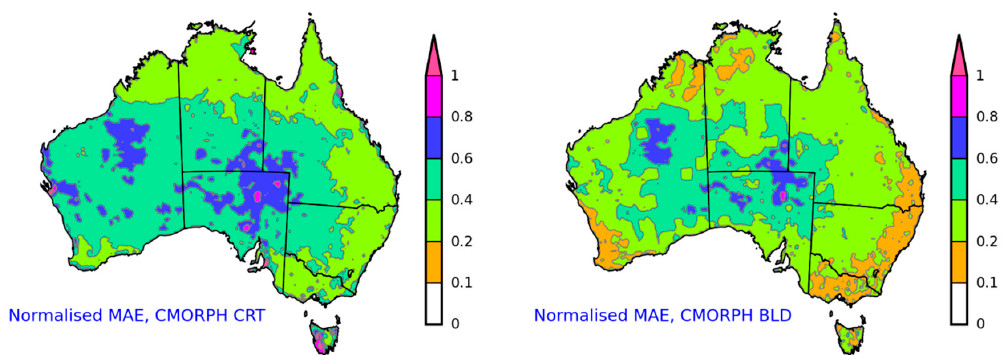
Figure 6. Mean bias, mean average error, and normalised mean average error for bias-corrected Climate Prediction Center morphing technique (CMORPH CRT) and gauge-blended CMORPH (CMORPH BLD) datasets from January 2001 to December 2018 using AWAP as truth.